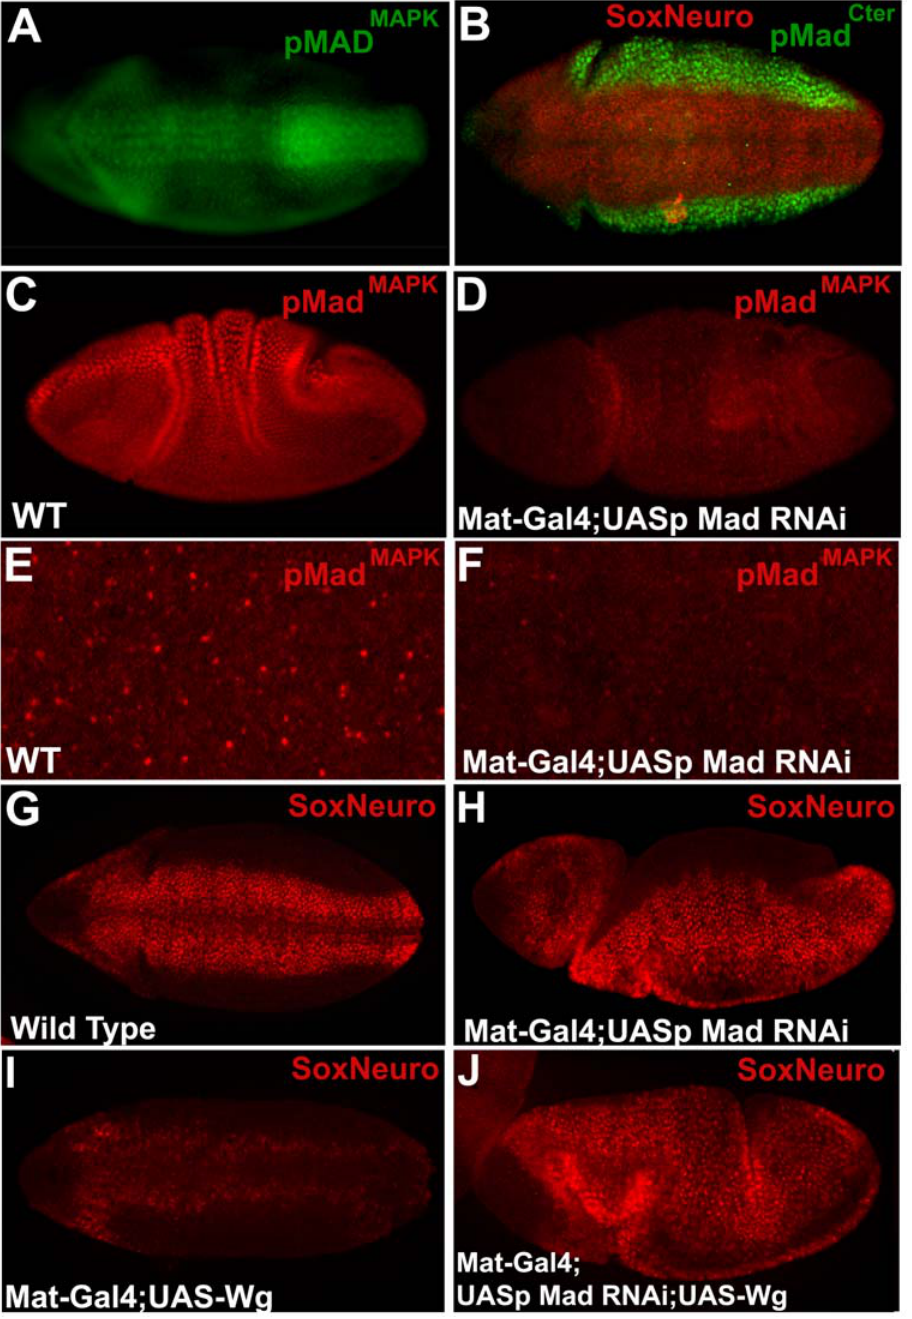
Figure 5. Mad Is Epistatic to Wg Signaling During Neurogenic Induction. (A) Mad was phosphorylated at its MAPK sites in developing CNS neuroblasts. (B) pMad Cter was excluded from the neurogenic ectoderm marked by SoxNeuro (stage 8). (C and D) Mad RNAi driven in the egg by pUASp knocked down pMad MAPK staining (stage 7). (E and F) Maternal Mad RNAi knocked down pMAD MAPK centrosomal staining (stage 7, see Figure S5 for asymmetric centrosomal staining). (G–J) Mad RNAi increased neurogenic ectodermal nuclei marked by SoxNeuro at stage 8, Wg overexpression reduced it, and the double Wg;RNAi embryos displayed the Mad depletion phenotype. All images were taken at identical exposure conditions. This experiment shows that Mad is epistatic to